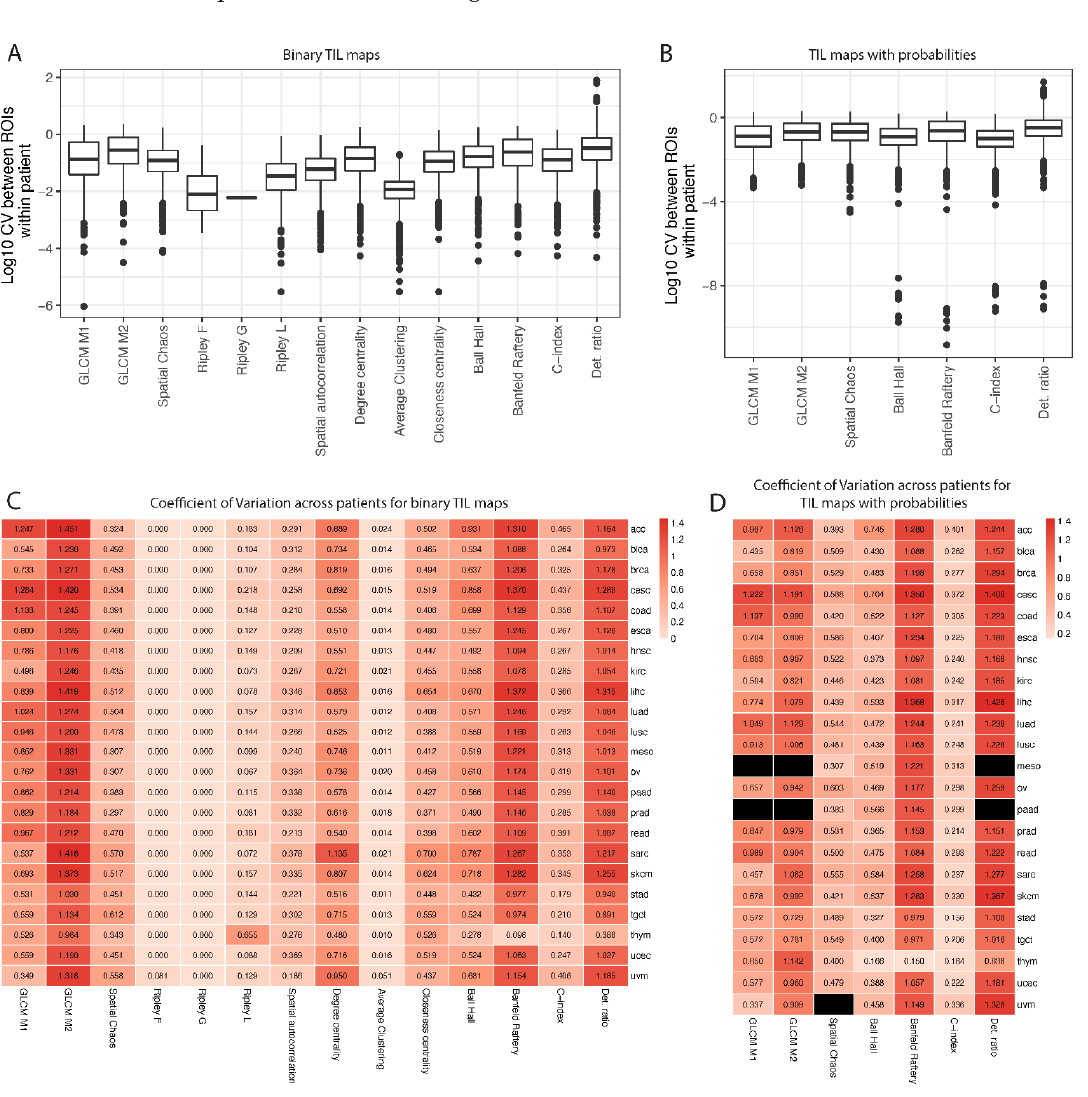
Figure 3. Variation of spatial measures across ROIs and patients estimated by robust coefficient of variation (CV). Boxplots shows reproducibility of measures calculated on different ROIs from the same patient for binary TIL maps ( A ) and probabilities ( B ). Heatmaps represent CV across patients for binary TIL maps ( C ) and probabilities ( D ). Black rectangles show situations where spatial measures could not be calculated or median across patients within the same cancer type was equal to 0.